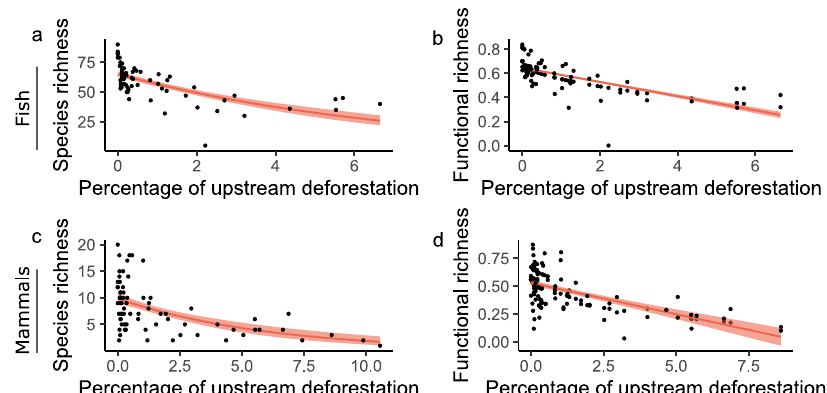
Fig. 4 Effects of upstream deforestation intensity on biodiversity. Panels represent species richness ( a , c ) and functional richness ( b , d ) of fi sh ( a , b ) and mammal ( c , d ) communities. Red solid lines indicate the fi tted values of mixed models accounting for site network position and basin identity. Light red shades indicate 95% con fi dence intervals. Deforestation corresponds to the percentage of deforested areas at the most relevant spatial extent (30 km). n = 64 sites and n = 74 sites for fi sh and mammal